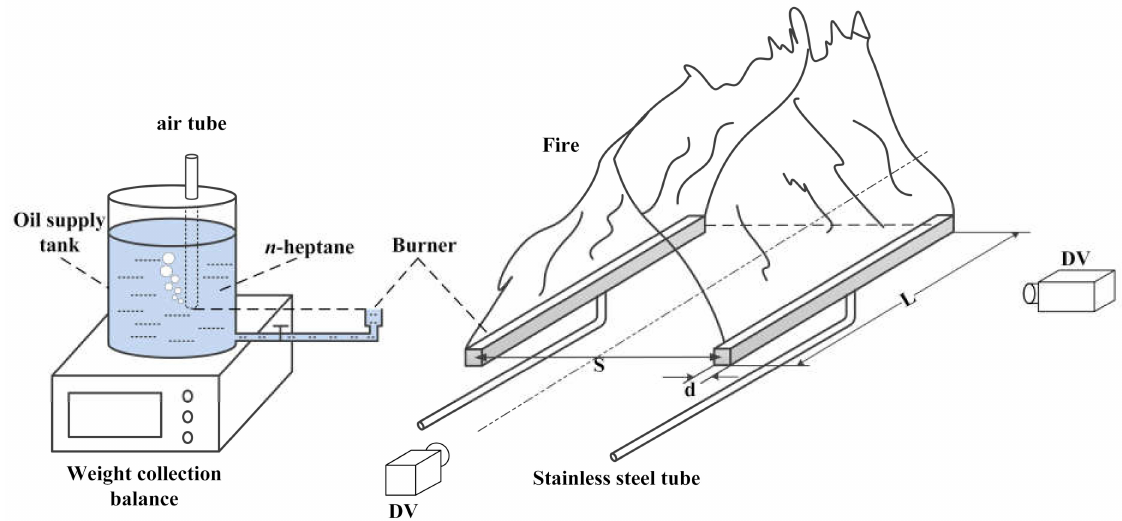
Figure 1. Schematic of experimental